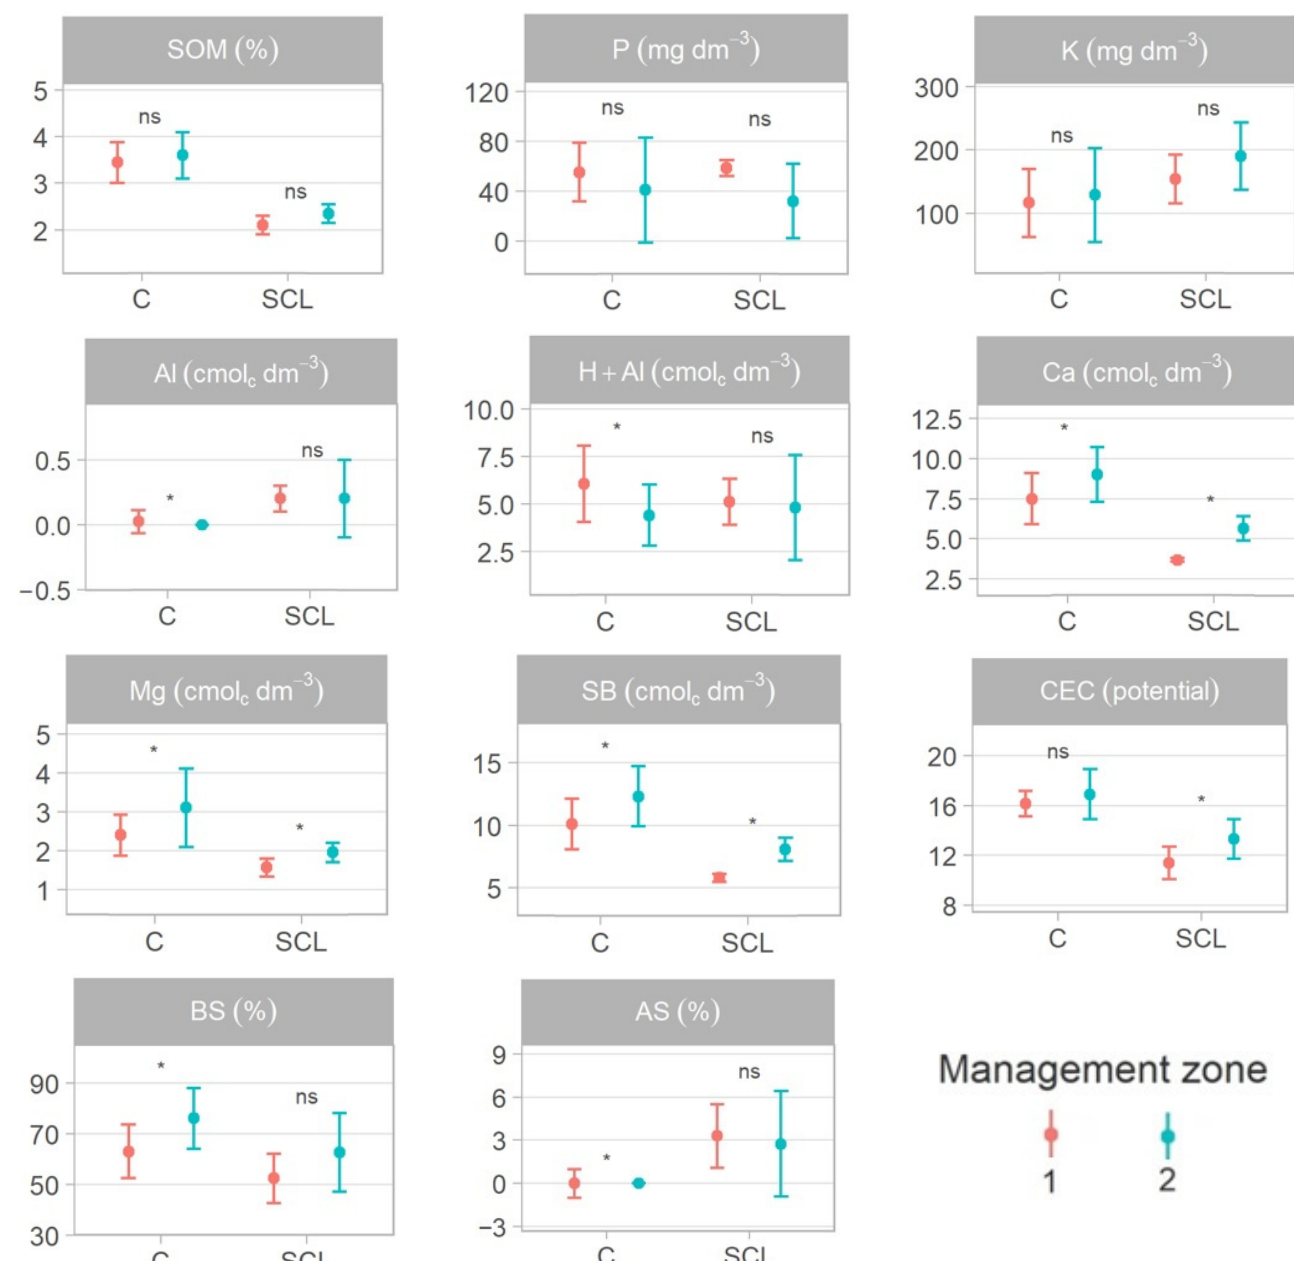
Figure 5. Mann–Whitney test results ( p < 0.05) for attribute averages as a function of management zones. Note: C: clay texture; SCL: sandy clay loam texture. ( * ) Mann–Whitney test results significant. (ns) Not significant.